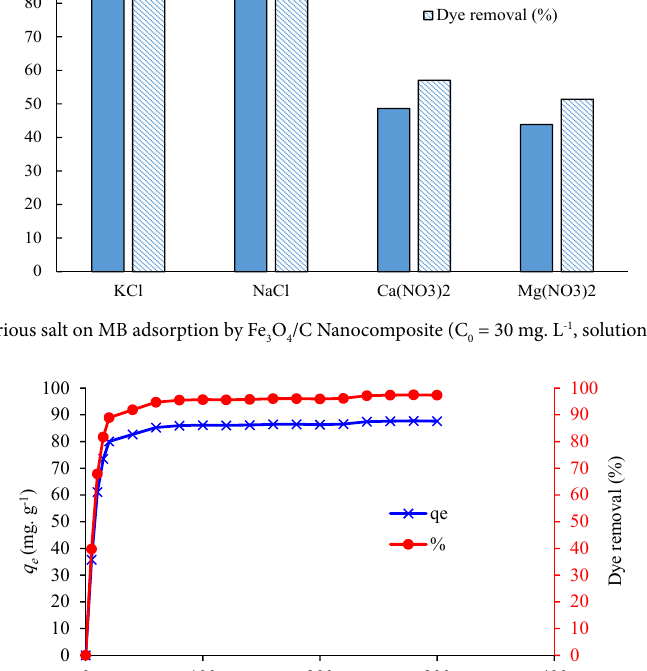
O /C (C = 30 mg. L -1 , solution volume = 30 3 4 0